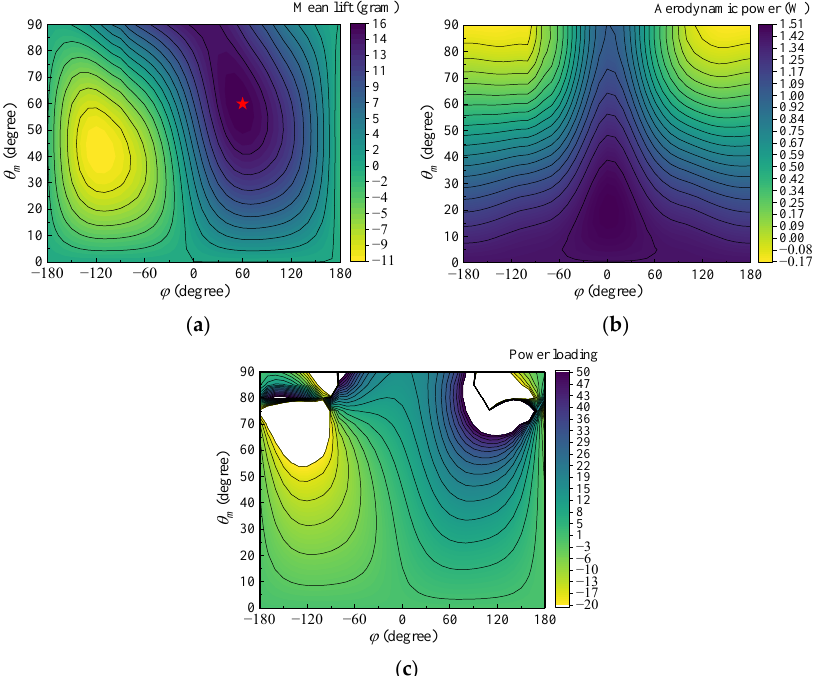
Figure 19. Parameter maps of aerodynamic performance as functions of phase angle φ and pitching amplitude θ m . ( a ) Lift with the phase angle and pitching amplitude. The star shape denotes the location of maximum lift. ( b ) Aerodynamic power with the phase angle and pitching amplitude. ( c ) Power loading with the phase angle and pitching amplitude. Note that only the values from − 20 to 50 are presented in the colored map to isolate the non-physical power loading generated by a near-zero aerodynamic power.